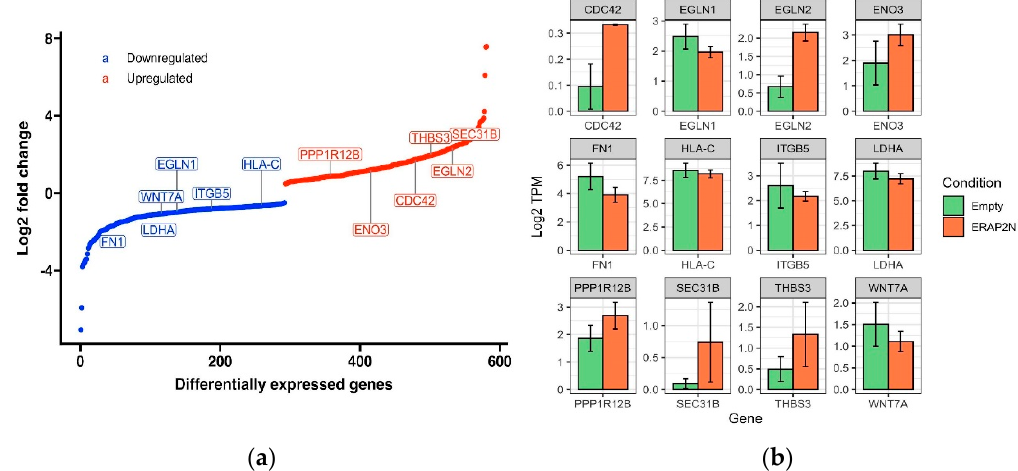
Figure 4. ( a ) Visualization of selected differentially expressed genes ranked by log2 fold change in ERAP2N-positive cells compared to ERAP2N-negative cells. The S-curve is a plot of genes differentially expressed in ERAP2N-positive cells compared to ERAP2N-negative cells, ranked by log2 fold change. The blue curve represents genes that are significantly down-regulated in ERAP2N-positive trophoblasts, while the red represents significantly up-regulated genes. ( b ) Bar Graph of Expression Level of Specific Genes from KEGG Pathways. Barplot of 12 differentially expressed genes, comparing the level of expression in ERAP2N-positive trophoblast cells to gene expression in ERAP2N-negative cells. Expression level reported as Log2 TPM (TPM = transcript count per million).